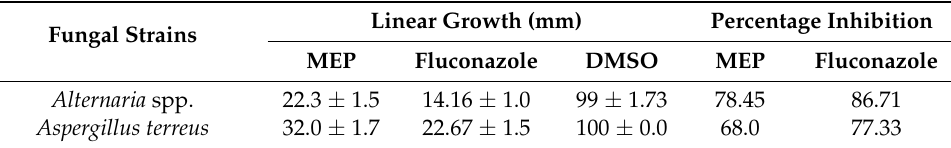
Table 5. Percentage inhibition against fungal strains.